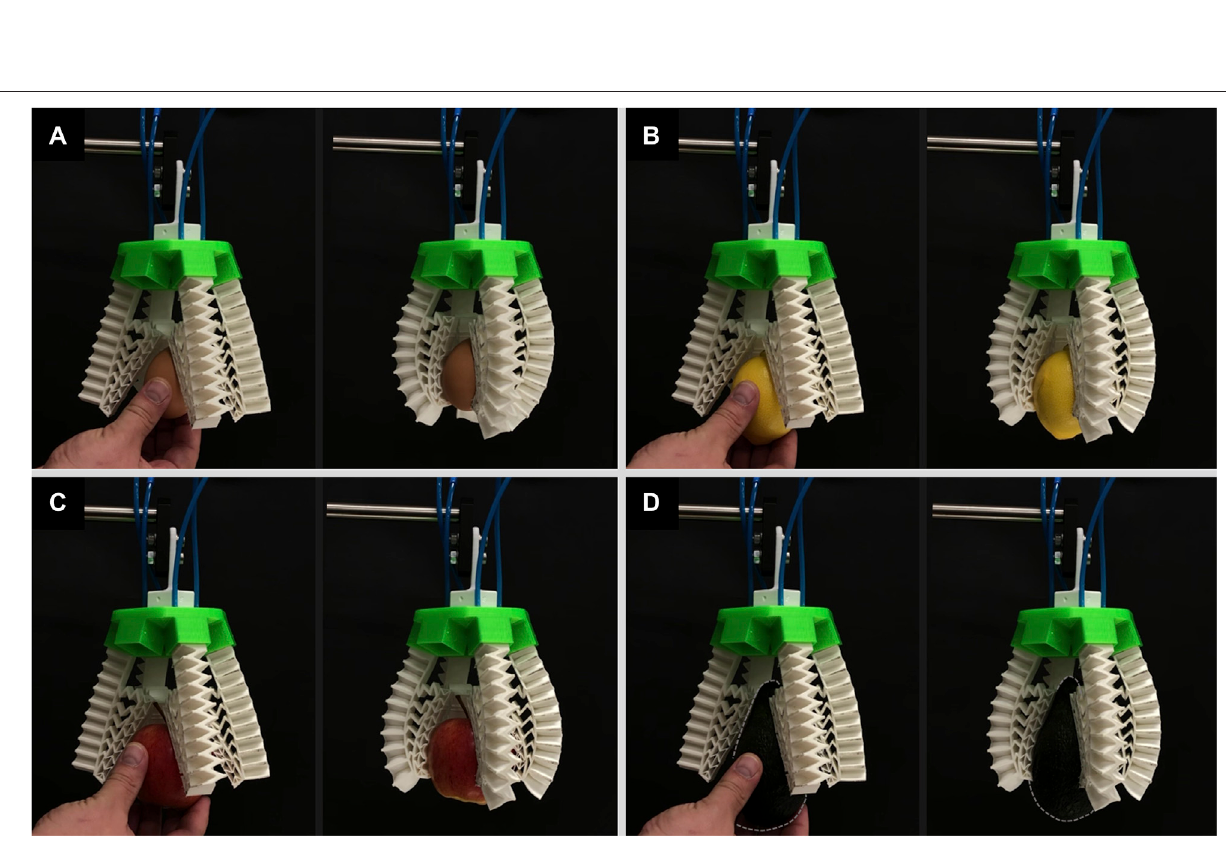
Frontiers in Robotics and AI |